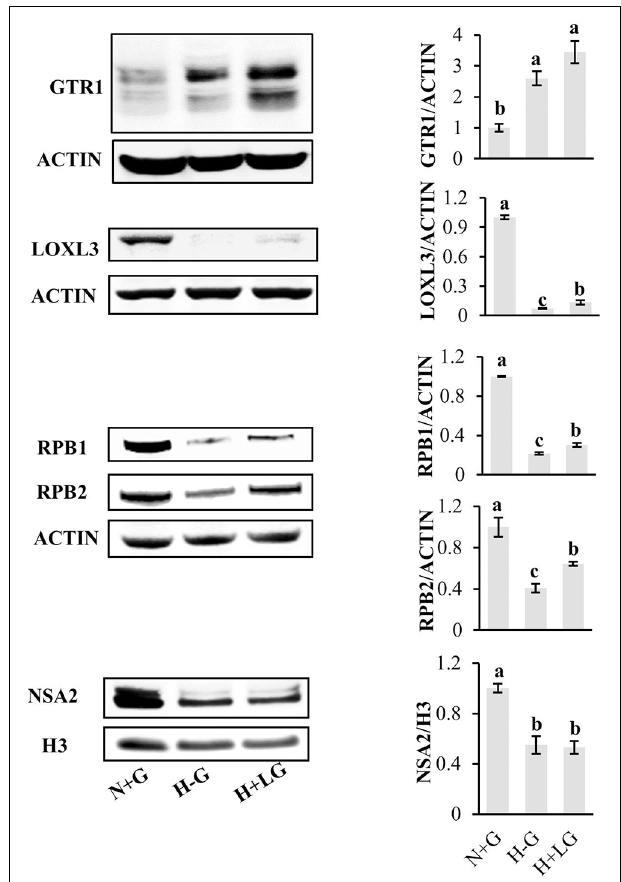
FIGURE 7 | Western blot analysis of five selected proteins from HT22 cells treated by three different conditions. Representative western blots (left) and quantification analysis (right) of GTR1, LOXL3, RPB1, RPB2, and NSA2 are shown. The band intensity of five selected proteins from Western blotting was calculated against either actin or histone 3 (H3) on the same blot. The ratio was further calculated against the N+G treatment whose relative expression level was set as 1. All data plotted are the average of three independent experiments ± SD. One-way ANOVA followed by Fisher’s least significant difference for multiple comparisons was used for statistical analysis. Different letters labeled represent significant differences at p < 0.05 level among